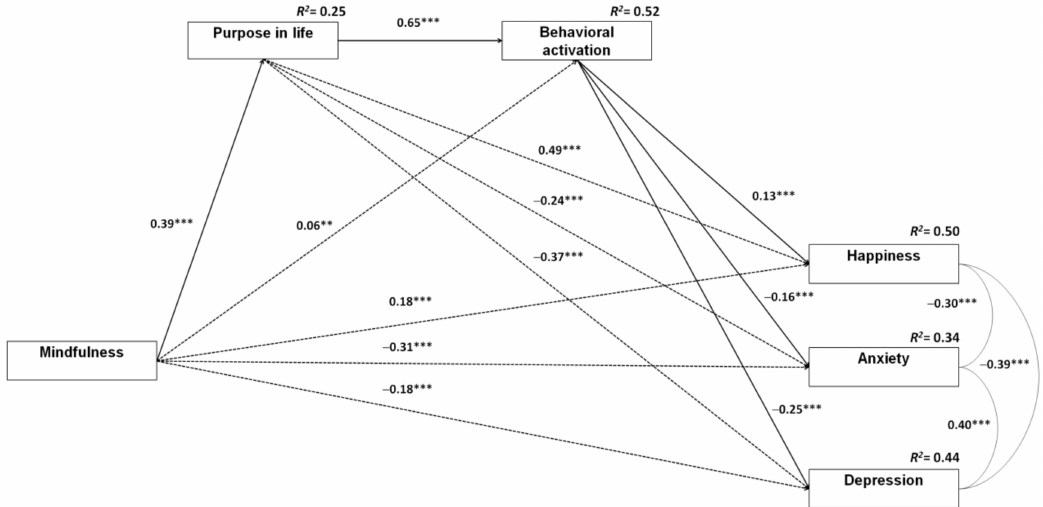
Figure 2. Multiple-step multiple mediator model representing the associations between mindfulness and happiness, anxiety, and depression, with purpose in life and behavior as mediators. Notes: The numbers represent point estimates of direct effects. Dashed lines represent mediated paths. ** p < 0.01; *** p < 0.001. Control variable (i.e., age) is not depicted to provide a clear representation of the